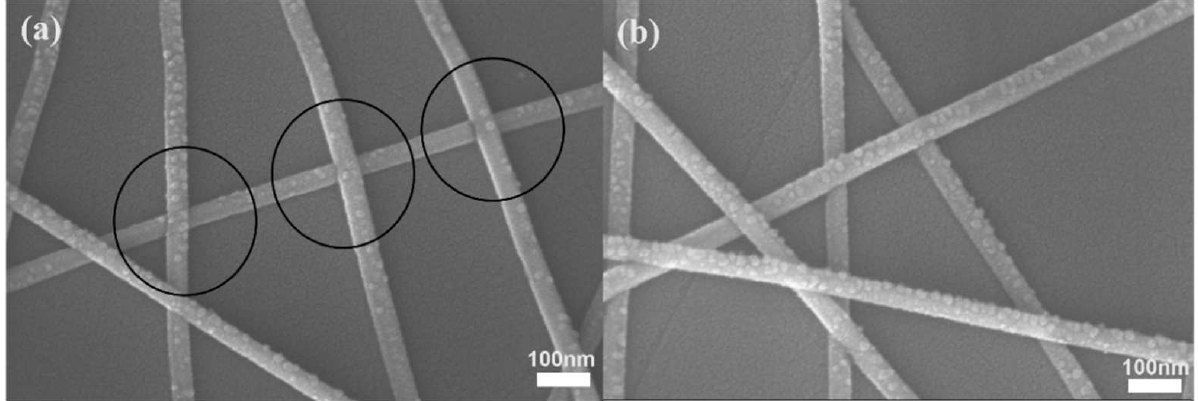
Figure 6. SEM images of AgNWs irradiated by the UV light. ( a ) AgNW welding. ( b ) AgNWs precipitate small particles.